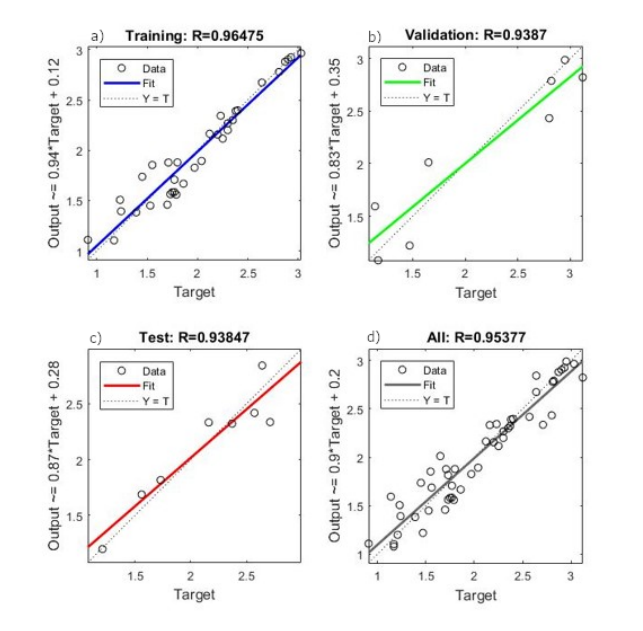
Figure 8. Regression and correlation for yield using Matlab R2017b